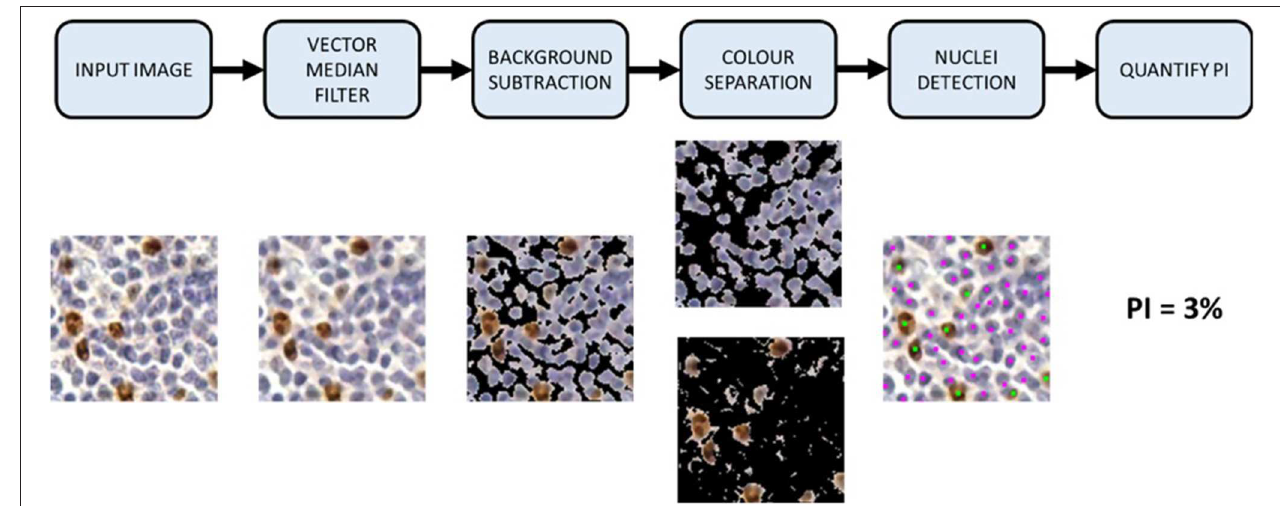
FIGURE 2 | Proposed automated Ki67 proliferation index calculator